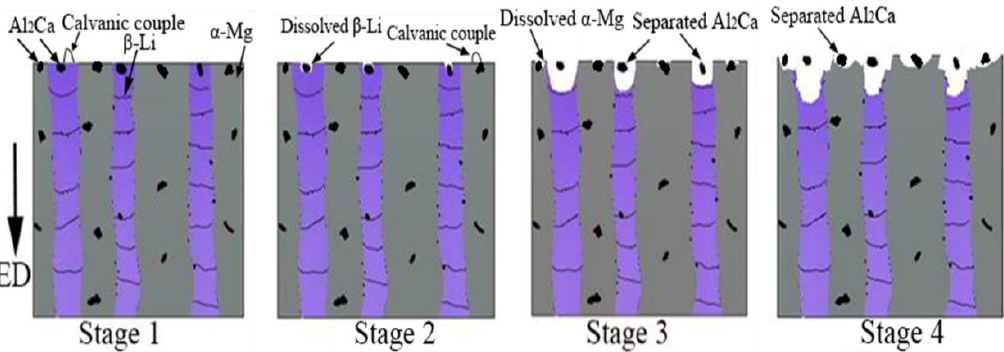
Figure 12. Schematic illustration of the role of the secondary phases in the extruded Mg–7Li–3Al–xCa alloys where their distribution is discontinuous.